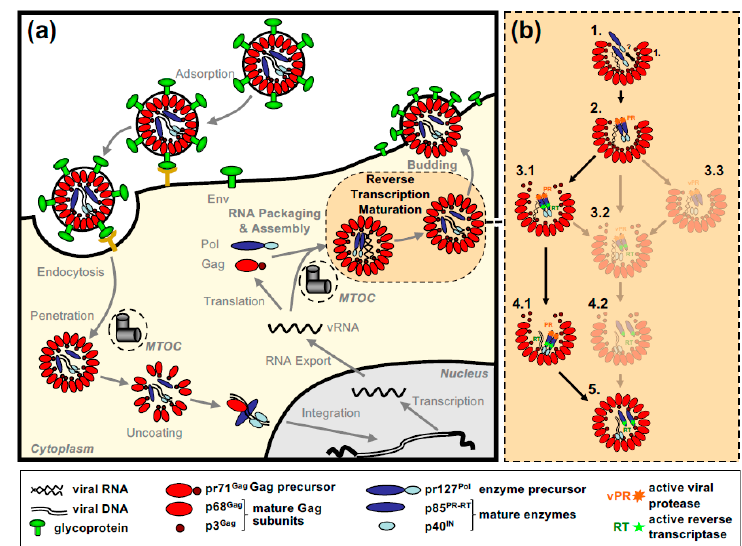
Figure 5. Schematic illustration of FV replication and virion maturation. ( a ) Simplified schematic illustration of the FV replication cycle. FVs attach to target cells by interaction with cell surface heparan sulfate. Virions having already undergone RTr during assembly and release (up to 20% of total) contribute to the majority of productive infection events. Virions enter the cell by endocytosis and capsids are released into the cytoplasm by a pH-regulated fusion of viral and cellular lipid membranes mediated by FV Env and unknown cellular entry receptor(s). Intact capsids migrate along microtubules to the centrosome where they remain in a latent state until the host cell enters mitosis. This induces further disassembly and enables chromatin access of the FV pre-integration complex upon nuclear membrane breakdown. Following integration and FV Tas-mediated transcription regulation viral RNAs are transported to the cytoplasm or the ER where protein translation takes place. Further details of the late steps of FV replication are discussed and summarized throughout the manuscript. ( b ) Model of sequential events resulting in infectious FV capsid maturation. 1. FV Pol is incorporated predominantly at the precursor state involving binding of Gag (or capsomeres) and Pol to vRNA and potentially additional Gag–Pol protein interactions; 2. Binding of Pol to the PARM elements of the vgRNA and potentially oligomerization by the IN domain result in PR domain dimerization associated with PR activation; 3. Different possibilities exist for subsequent Gag and Pol precursor maturation. First either Gag (3.1) or Pol (3.3) is cleaved followed by the cleaving of the other component, or both proteins (3.2) are cleaved simultaneously. 4. Gag precursor processing activates RT activity either in the Pol precursor (4.1) or the mature PR-RT subunit (4.2); 5. This leads to RTr of the packaged vRNA genome in up to 20% of all released particles, which contribute to the great majority of FV infectivity. The processing pathways that are less likely in the opinion of the authors are indicated by lighter